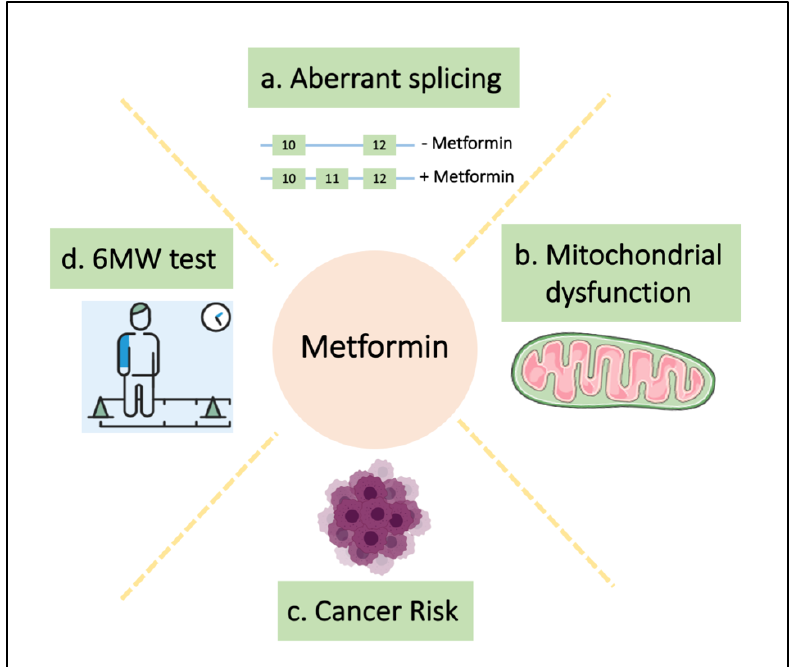
Figure 1. Metformin restores multiple phenotypes in DM1. ( a ) Loss of exon 11 in INSR gene is associated with insulin resistance in DM1 patients and metformin restores the inclusion of this exon [117]; ( b ) metformin treatment restores the impaired mitochondrial metabolism of DM1 fibroblasts [71]; ( c ) DM1 patients have an increased cancer risk and metformin reduces this risk in DM1-T2D patients [114], and ( d ) finally, metformin improves the 6-min walk test in a clinical trial [116].